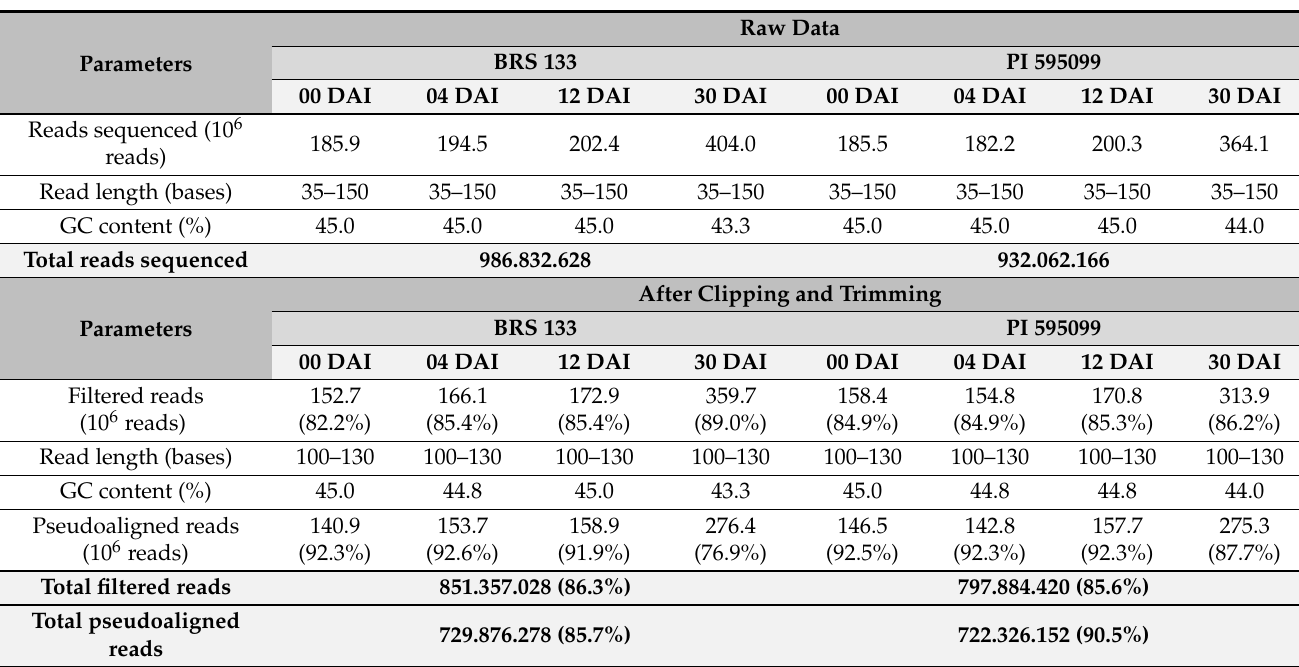
Table 1. Summary of paired-end reads produced by the sequencing of cDNA libraries from two soybean genotypes.